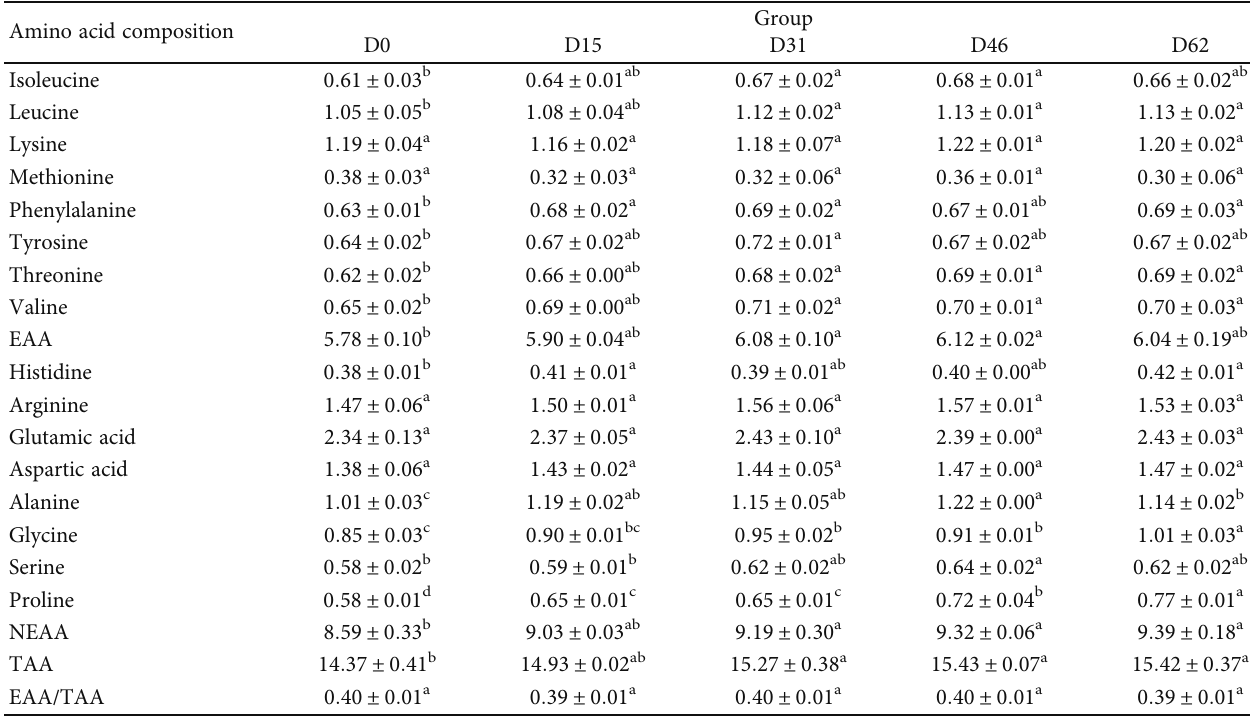
Table 4: Amino acid composition of female E. sinensis muscle in rice-crab coculture system at di ff erent developmental periods (% wet